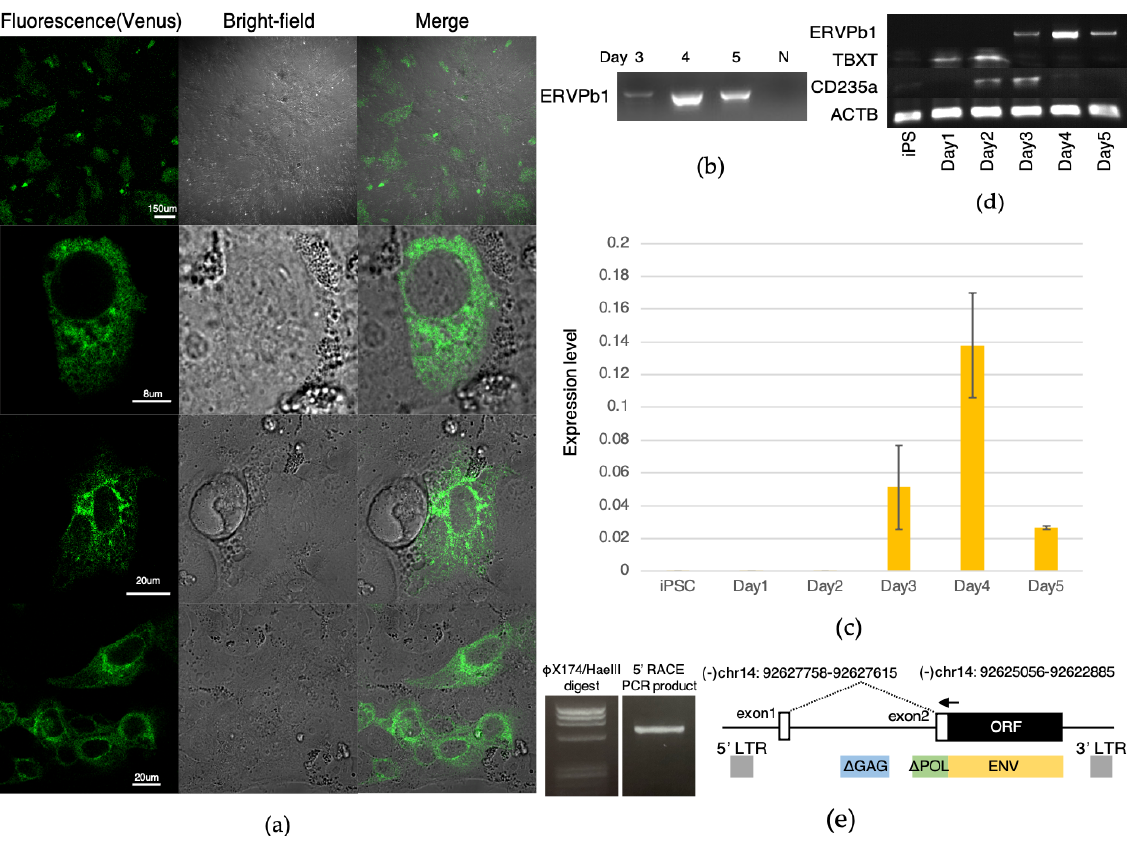
Figure 3. ERVPb1–Venus fusion protein detected under an iPSC differentiation condition induced in macrophages cells. ( a ) ERVP1-NV iPSCs were differentiated under a condition for macrophage differentiation containing BMP4 without bFGF in day 4 cultures. ( b ) Analysis of Venus expression by RT-PCR. ( c ) Detection of ERVPb1 by real-time PCR in normal human iPSCs in the differentiation medium containing BMP4 on days 1–5. The values were normalized to β -actin expression